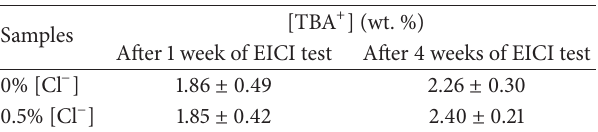
Figure 7: Compressive strength of cement mortar before and after EICI treatment in sodium hydroxide solution. Table 1: [TBA + ] content by time of EICI treatment in sodium hydroxide solution.